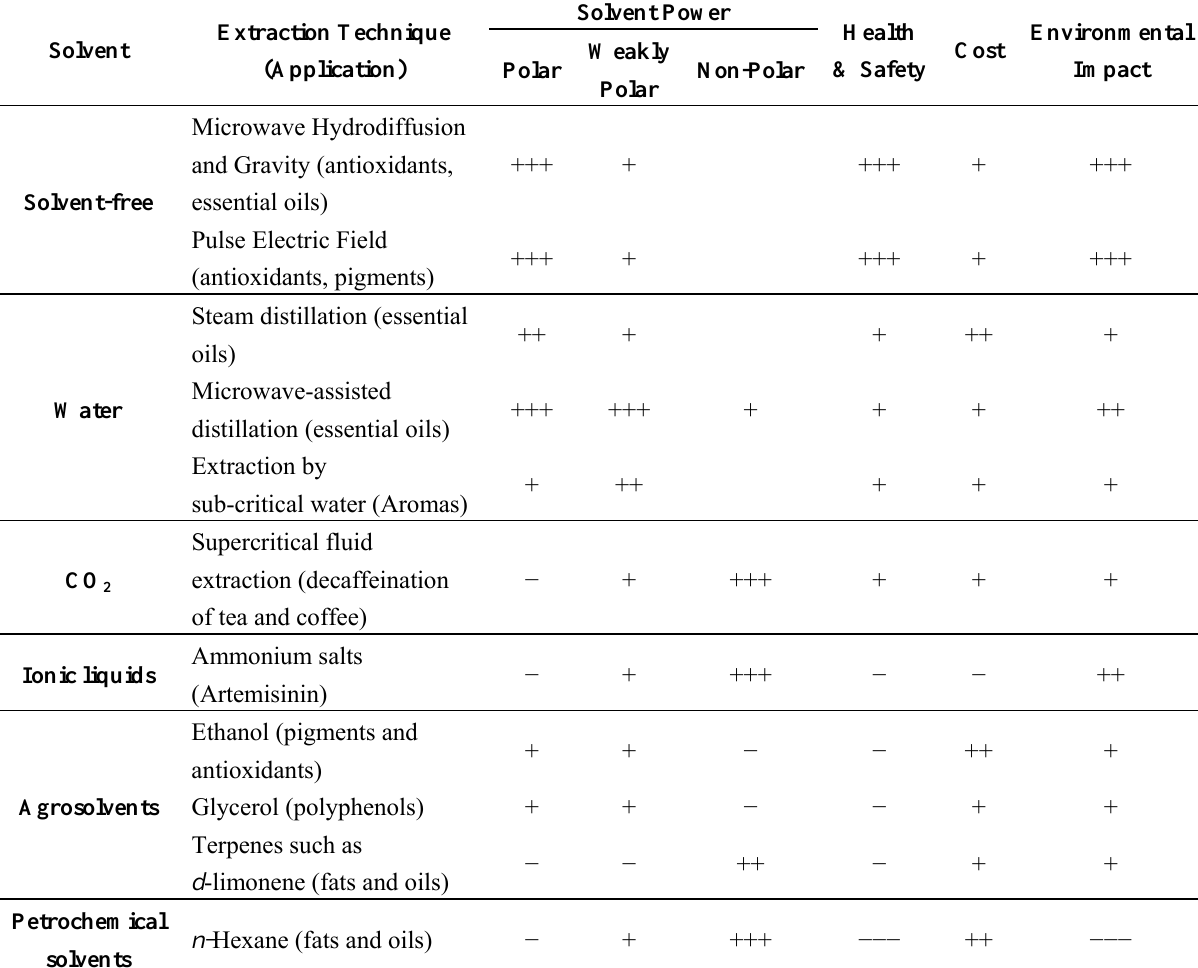
Table 1. Alternative solvents for Green